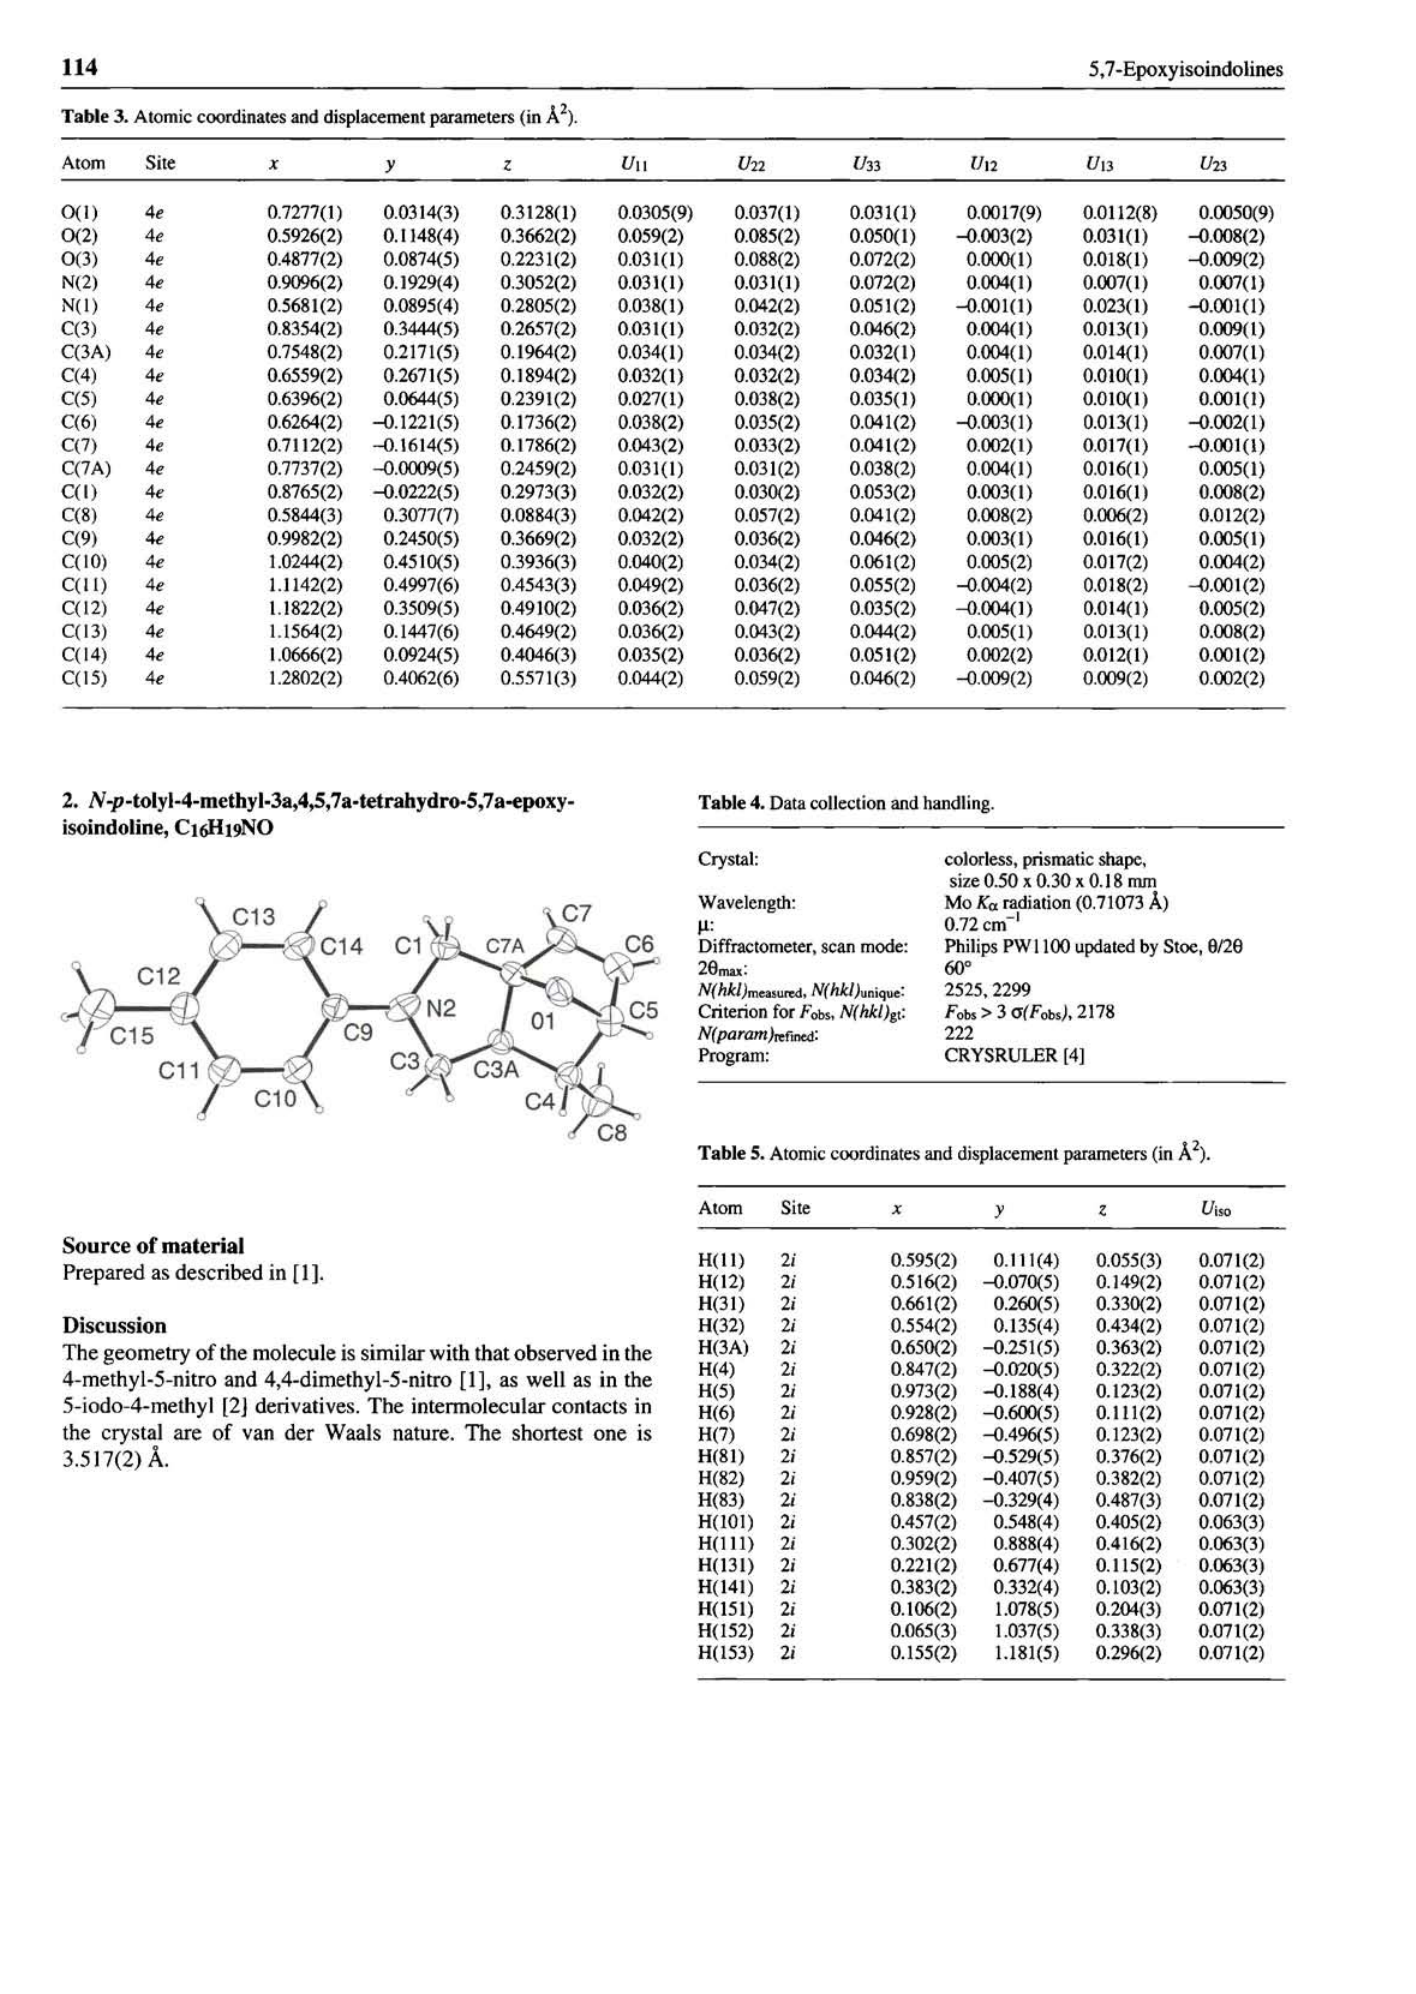
Table 4. Data collection and handling.